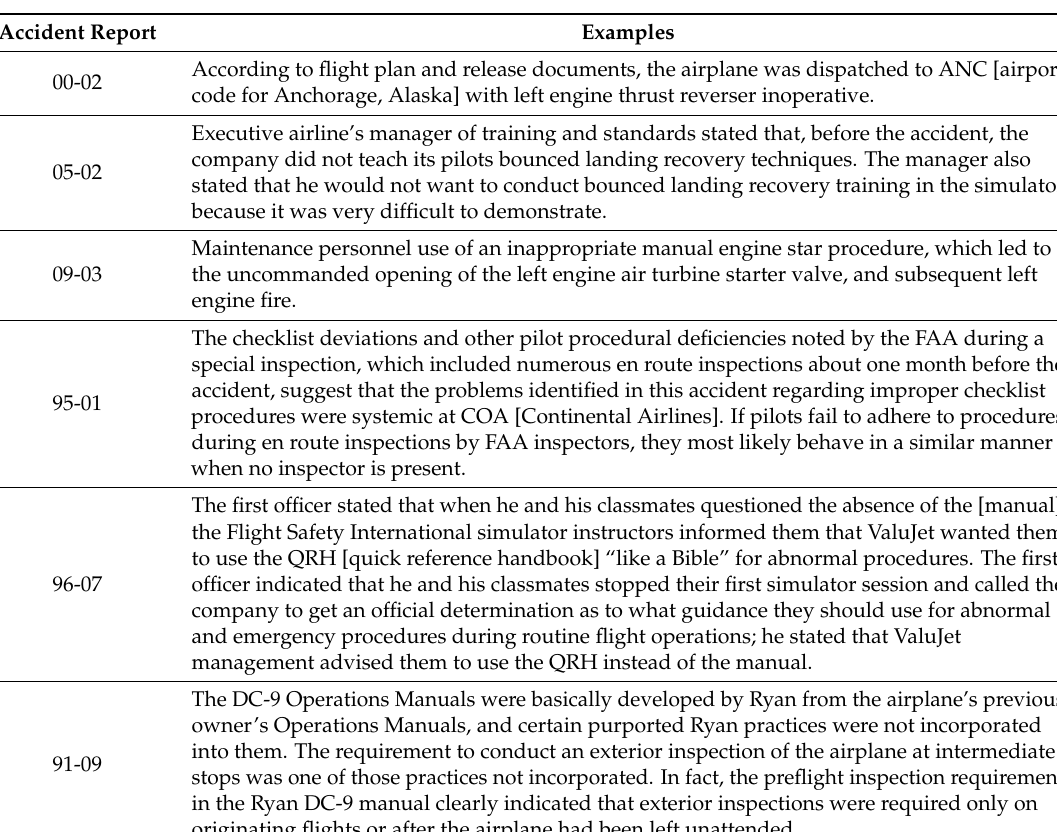
Table 10. Examples of airline management as a contributing factor.